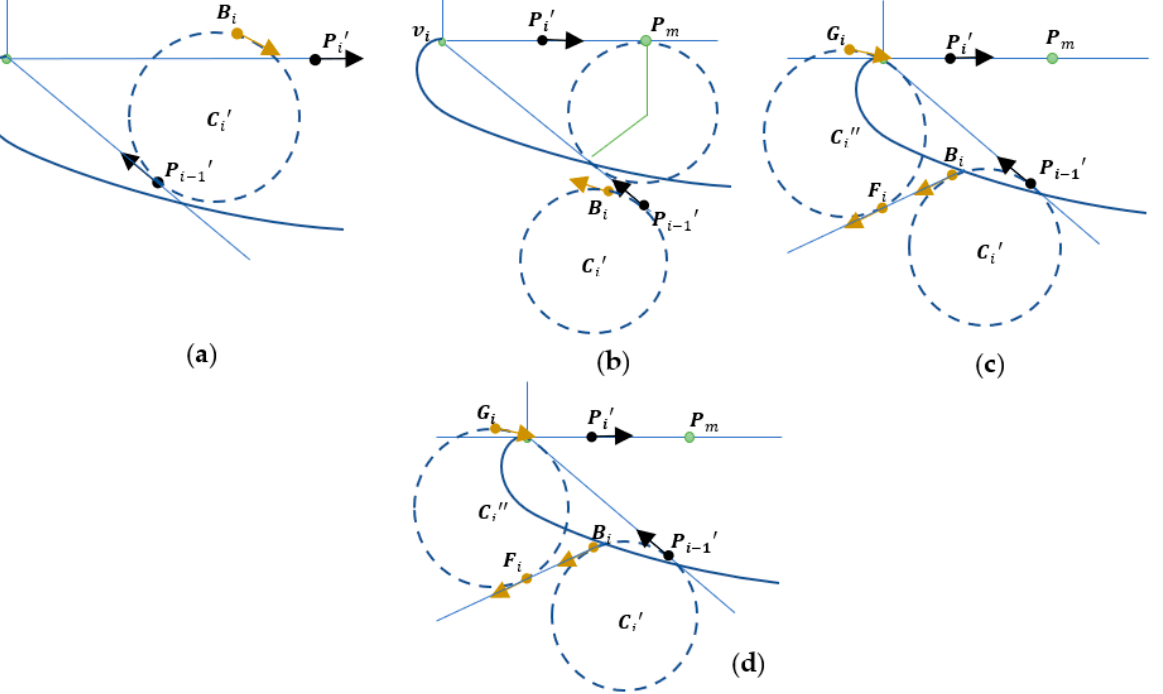
Figure 5. Special cases: ( a ) Rule 2 cornering motion, ( b ) Rule 3 cornering motion, ( c ) Rule 4 cornering motion, and ( d ) lane-change motion.